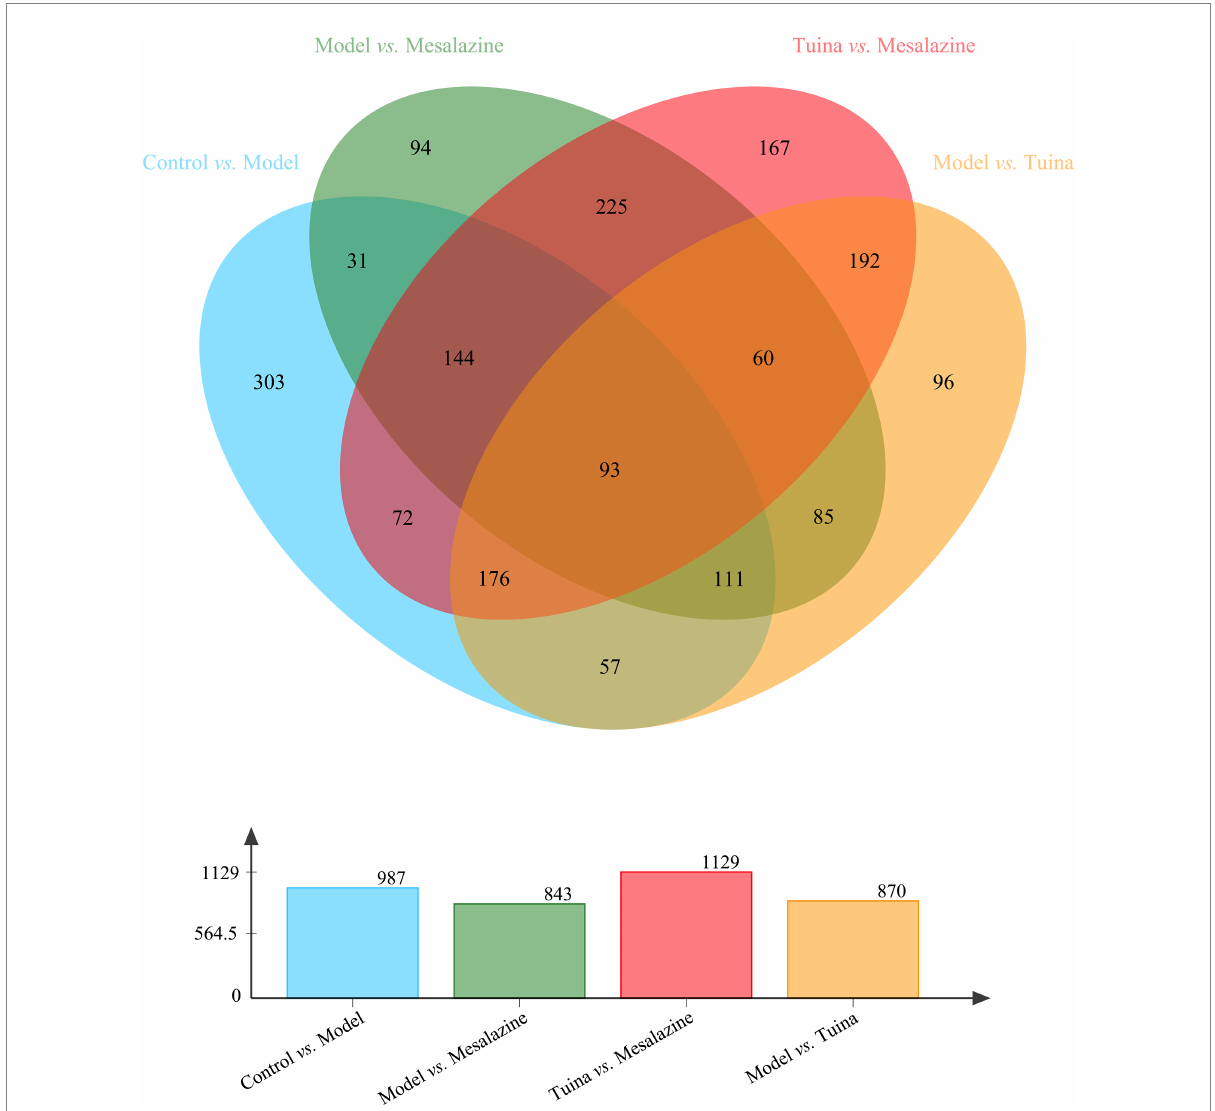
FIGURE 7 Venn analysis among each group. The bar diagram below represents the number of DEPs compared between the two